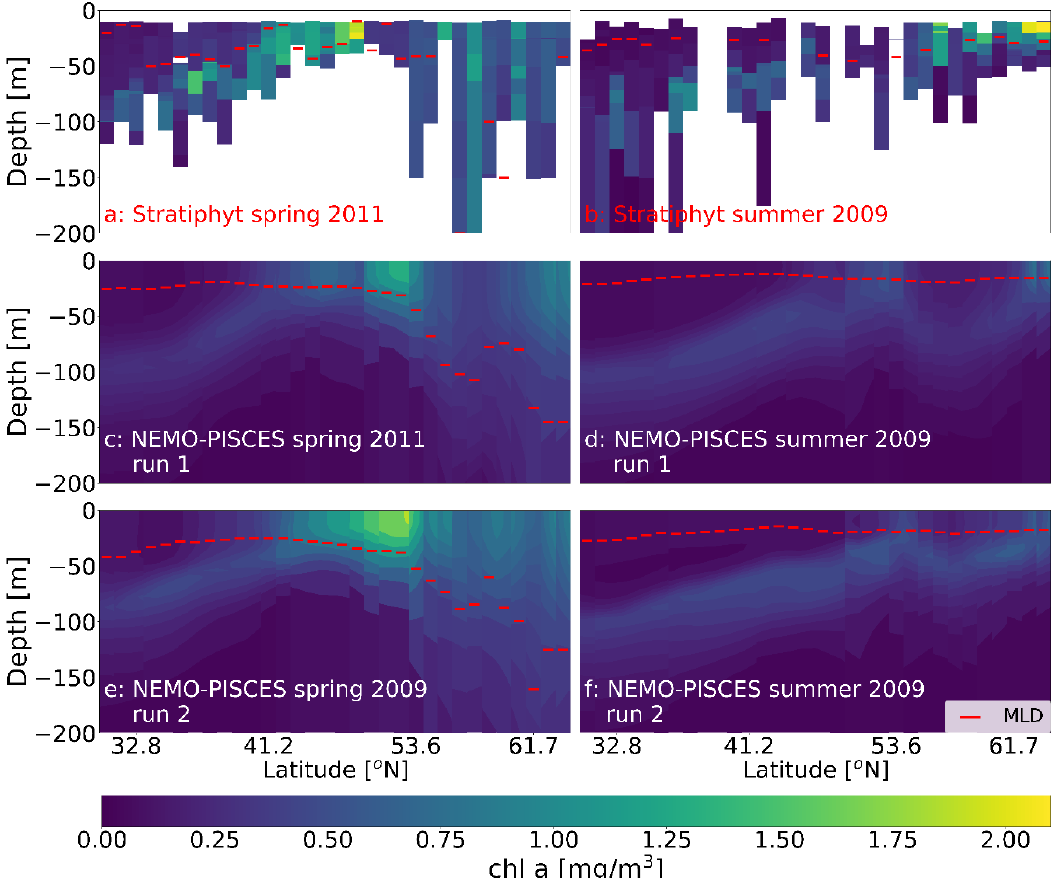
Figure 7. Chlorophyll a (Chl a) in the upper 200 m and mixed layer depth (MLD, red bars) of Stratiphyt ( a , b ), NEMO-PISCES (nucleus for European modelling of the ocean - pelagic interactions scheme for carbon and ecosystem studies) run 1 ( c , d ), and NEMO-PISCES run 2 ( e , f ) during spring ( a , c , e ) and summer ( b , d , f ). Model Chl a and MLD are April – May (spring) and July – August (summer) averages.